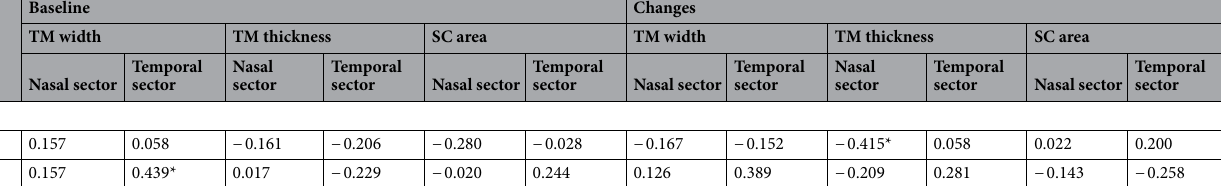
Table 3. Correlation coefficient between IOP Changes and TM Width, TM Thickness, and SC Area Measurements. Spearman’s correlation test, * P < 0.01. IOP, intraocular pressure; TM, trabecular meshwork; SC, Schlemm’s canal; PG, prostaglandin; DTFC, dorzolamide/timolol fixed